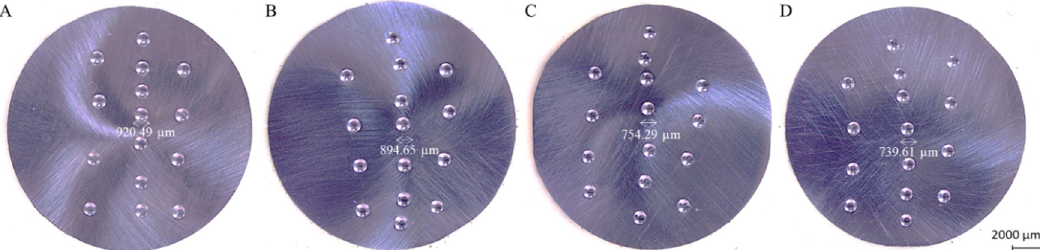
Figure 3. Exemplary pictures of indentations obtained in Brinell’s hardness tests; ( A ) CuMg4.5 sample casted with 2 mm feed; ( B ) CuMg4.5 sample casted with 4 mm feed, ( C ) CuMg5 samples casted with 2 mm feed, ( D ) CuMg5 samples casted with 4 mm feed.